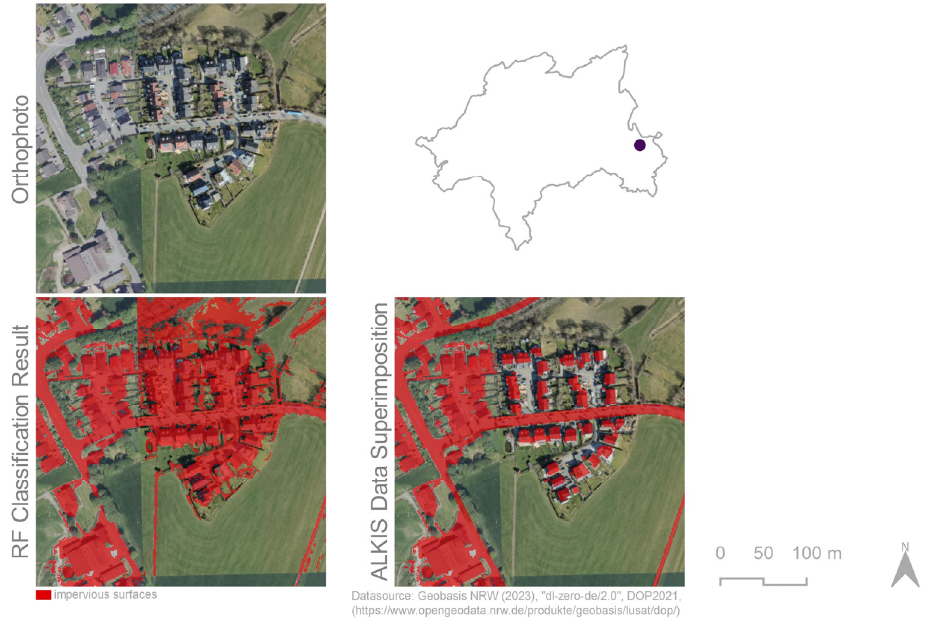
Figure 13. Overlapping of summer and spring TDOP inside Wuppertal’s city boundary.